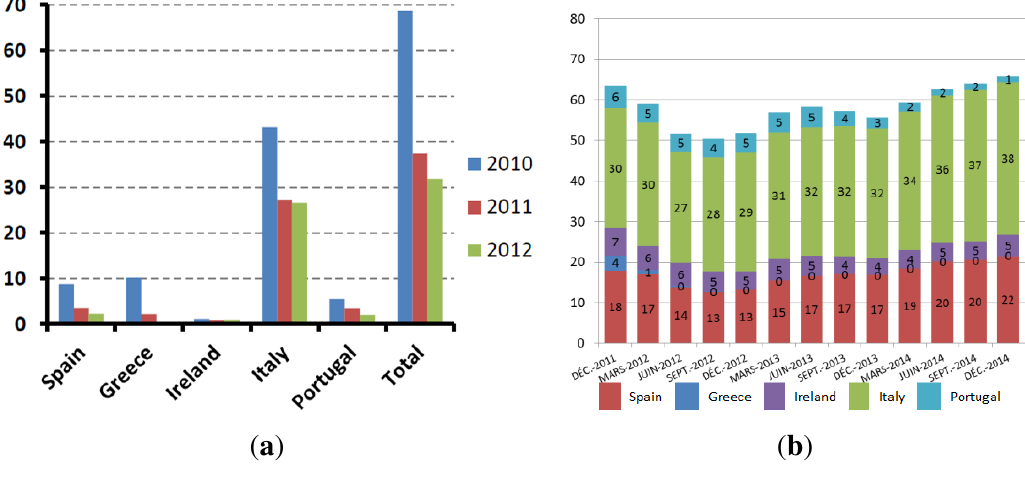
Figure A4. Exposures to European peripheral countries for major French banks and insurers ( e bn). Sources: ACP [44] for ( a ) and ACPR [45] for ( b ). (a) Exposures of major French banks to European peripheral countries; (b) exposures of major French insurers to European peripheral